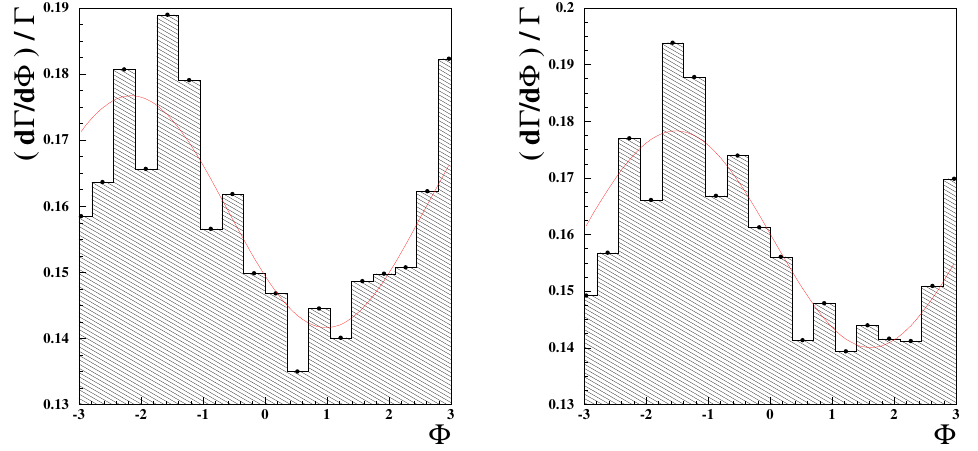
Figure 2 . S4 (left), S6 (right): the normalized angular distributions from the pseudo dataset p p generated with p 2 ; (cid:22) p 2 = m t (cid:6) 5(cid:0) t and (cid:1)(cid:8) = (cid:25)= 9. The results of (cid:12)tting to the angular t t distributions with eq. (2.32) are shown in the (red) solid lines.